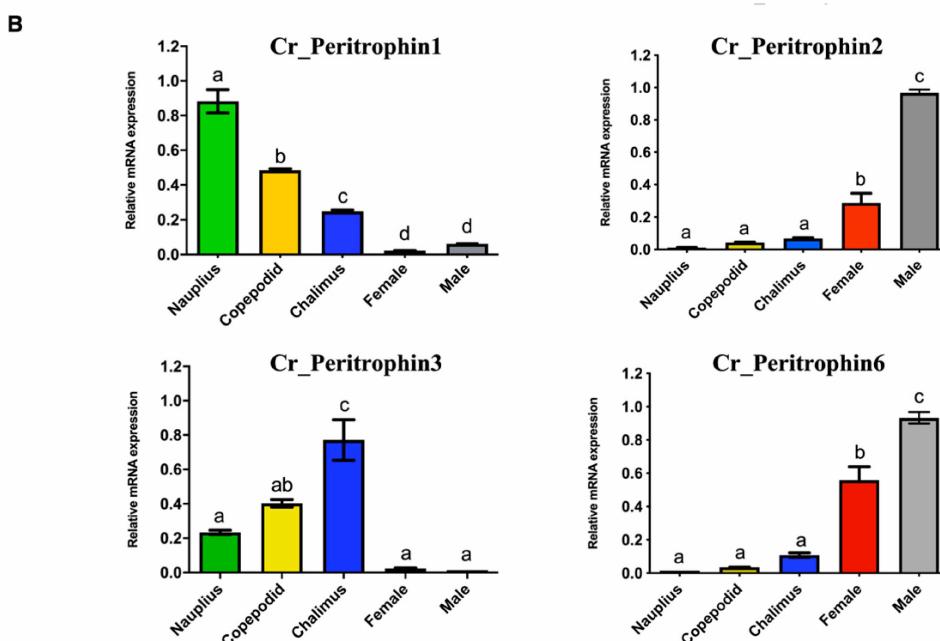
Figure 3. Transcriptional expression of contigs annotated as peritrophin genes during C. rogercresseyi developmental stages. ( A ) . Heatmap showing the TPM values using transcriptomic data of C. rogercresseyi developmental stages. Hierarchical clustering was based on Euclidean distances with an average linkage. ( B ) . RT-qPCR validation of four Cr_Per in sea louse developmental stages. Bars represent the relative expression abundance of the transcripts (mean ± standard deviation). The lowercase letters above the error bars for each gene showed significant differences at p <